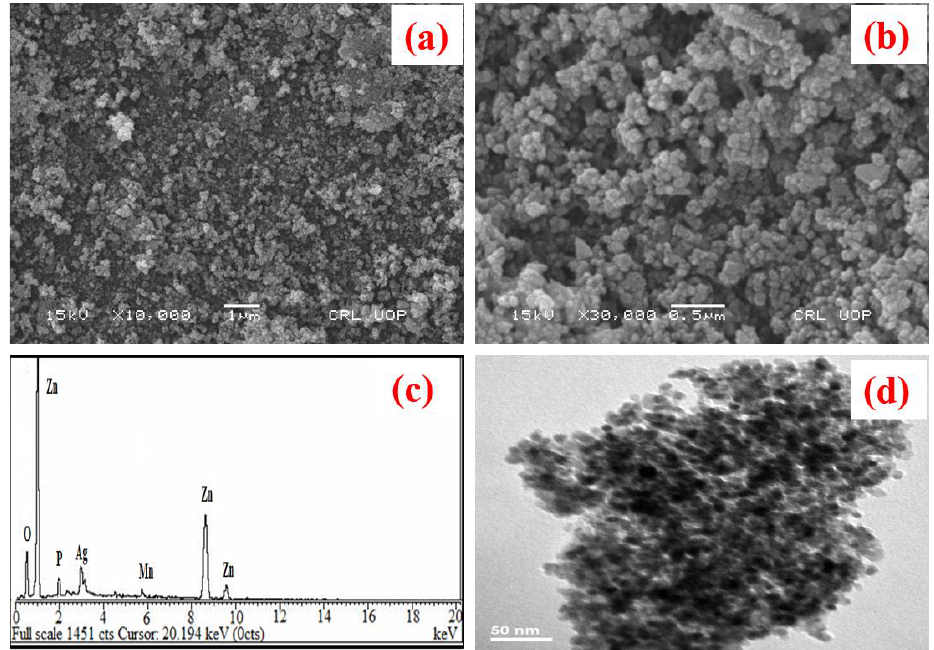
Figure 3. ( a , b ) SEM images of 3APMZ nanocomposites at different magnifications. ( c ) EDX graph of 3APMZsample. ( d ) TEM image of 3APMZsample.